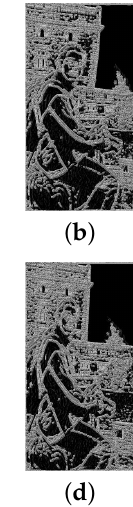
Figure 1. Resized image obtained by different retargeting methods.